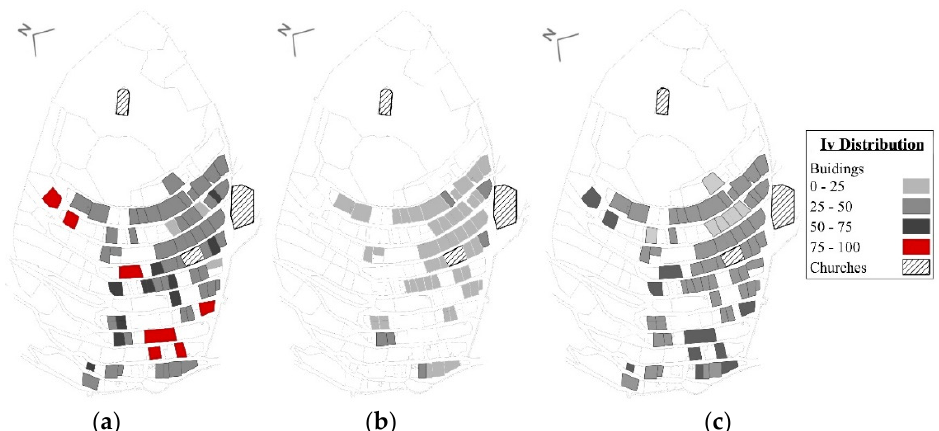
Figure 10. Normalized I V distribution in the case study of Campi Alto di Norcia, according to ( a ) the GDNT method, ( b ) the Formisano method and ( c ) the Vicente method.